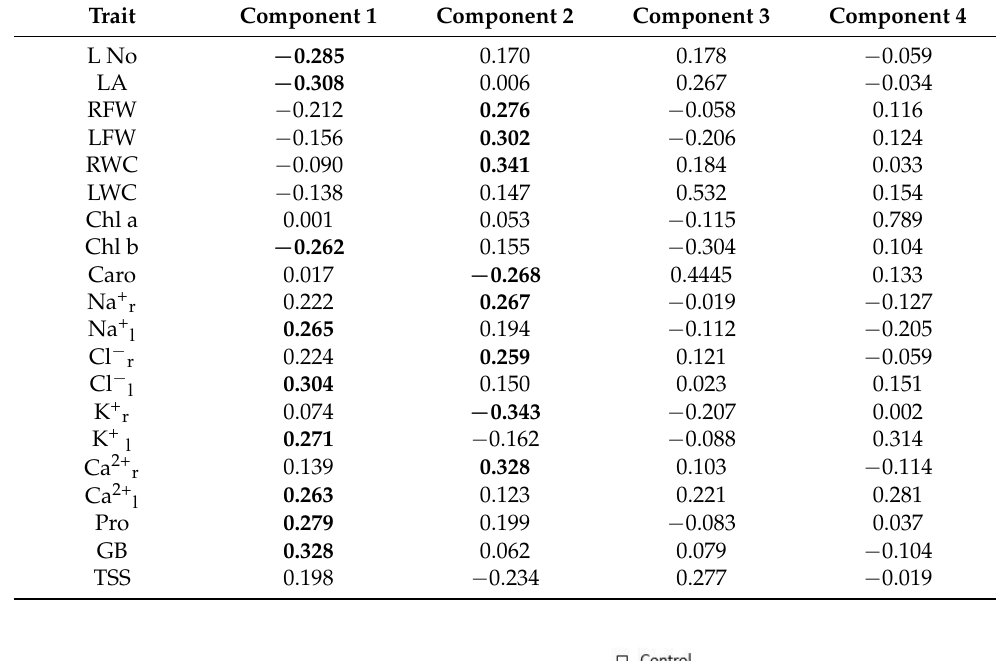
Table 1. Component weights in the PCA performed on Limonium angustebracteatum plants subjected to one month of stress treatments. Stronger correlations are shown in bold font. Abbreviations: LNo, number of leaves; LA, leaf area; RFW, root fresh weight; LFW, leaf fresh weight; RWC, root water content; LWC, leaf water content; Chl a, chlorophyll a; Chl b, chlorophyll b; Caro, carotenoids; Na + r, sodium in roots; Na + l sodium in leaves; Cl − r , chlorine in roots; Cl − l , chlorine in leaves; K + r , potassium in roots; K + l , potassium in leaves; Ca 2+ r , calcium in roots; Ca 2+ l , calcium in leaves; Pro, proline; GB, glycine betaine; TSS, total soluble sugars.